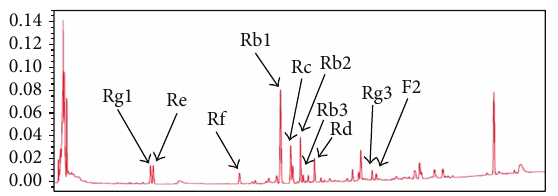
Figure 1: HPLC chromatographic profile of red ginseng saponin fraction-A